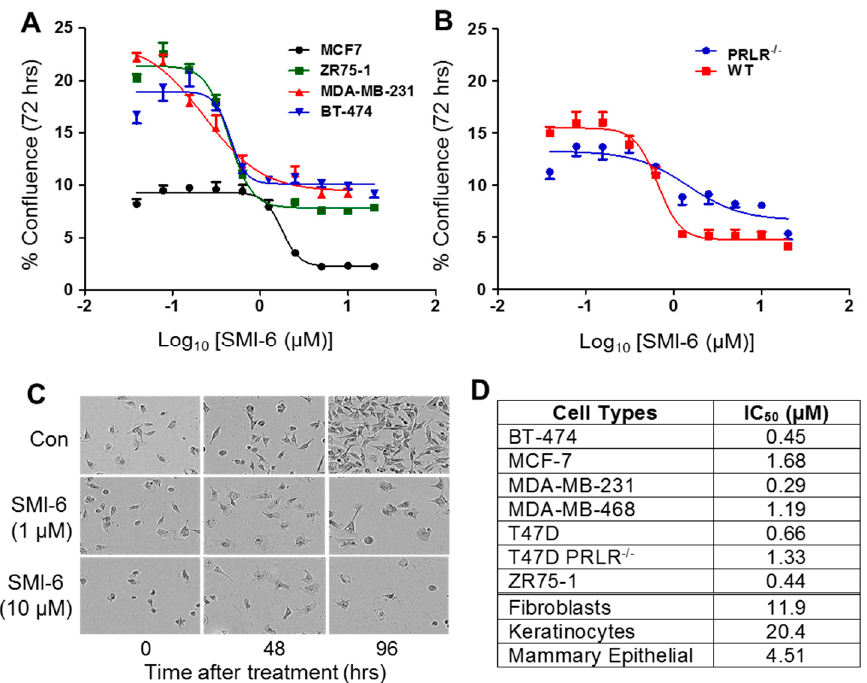
Figure 5. Suppression of cell proliferation by SMI-6, as determined by the IncuCyte Live-Cell Imaging Systems. ( A ) various breast cancer cells. ( B ) Wild type (WT) and PRLR-deficient (PRLR − / − ) T47D cells. ( C ) Density of MDA-MB-468 cells treated with 0, 1, or 10 μ M SMI-6 (10X). ( D ) Summary of the IC50 values of all cells analyzed for proliferation.